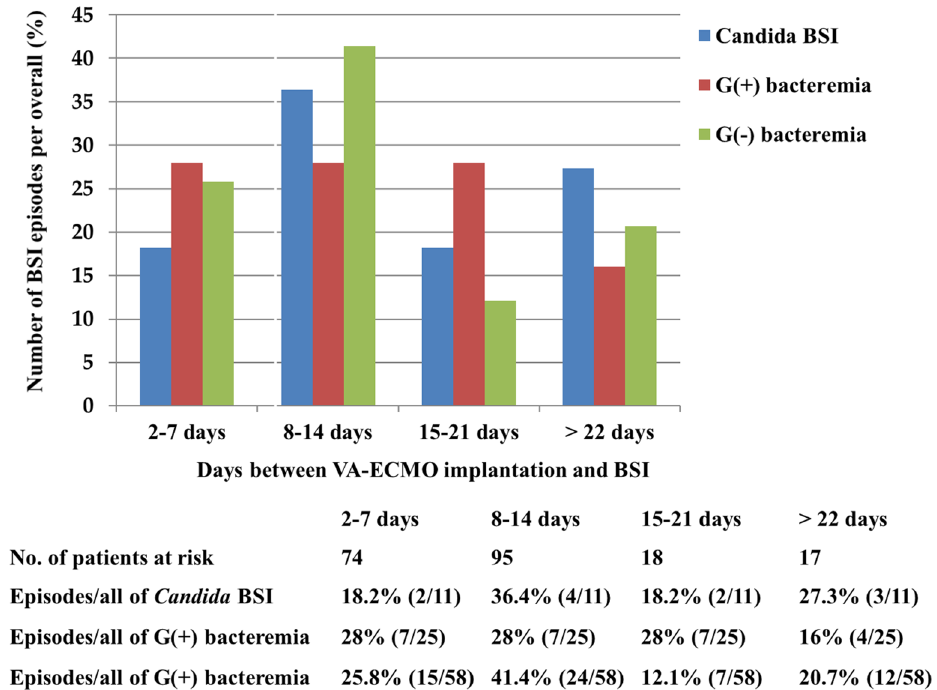
Figure 1. Number of each type of BSI episodes to the overall number of BSI episodes (%) among VA ECMO patients that was stratified by days between ECMO implantation and